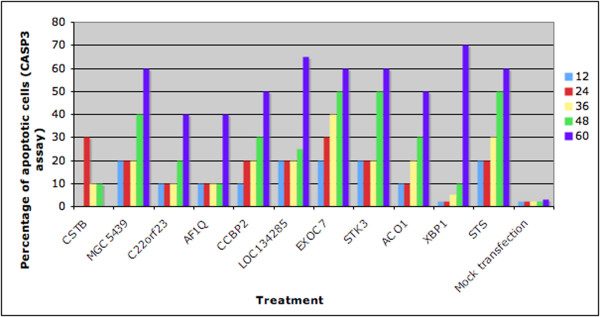
Percentage of apoptotic cells after over-expression of the 10 pro-apototic genes. STS treatment and mock transfection in 6 well plate CASP3 assays.